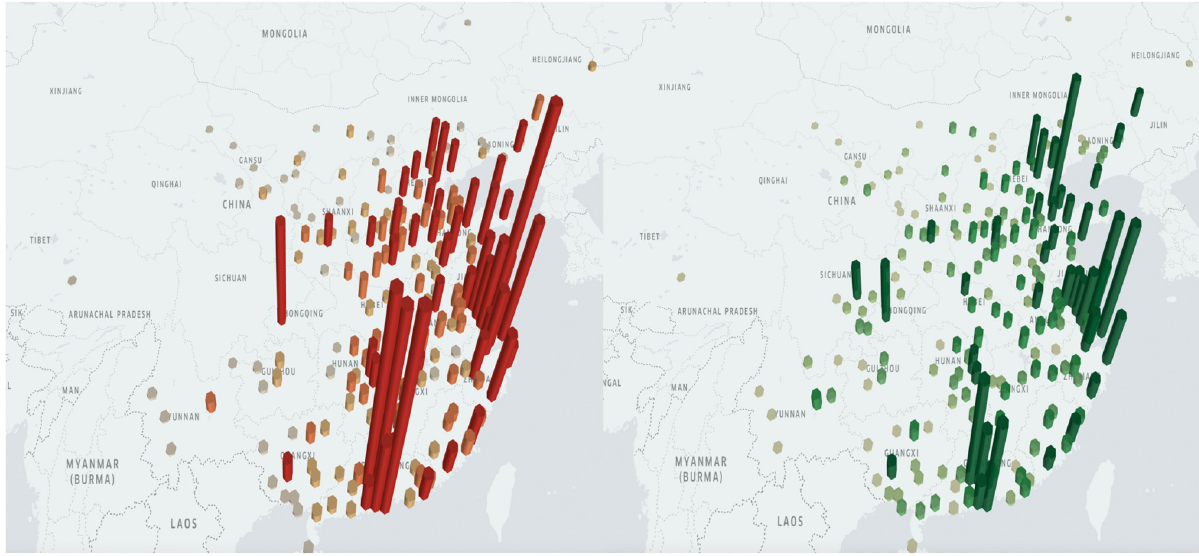
Fig 1. Maps of the spatial distribution. of (Left) industrial employment and (Right) industrial revenue in China’s prefecture-level cities.